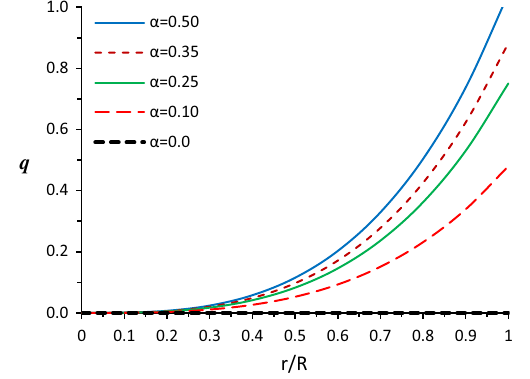
Fig. 1 The behavior of electric charge q ( r ) verses radial coordinate r / R . For obtaining the trend of the charge inside the object we have taken mass-radius ratio M / R = 0 . 2 for different values of parameter α